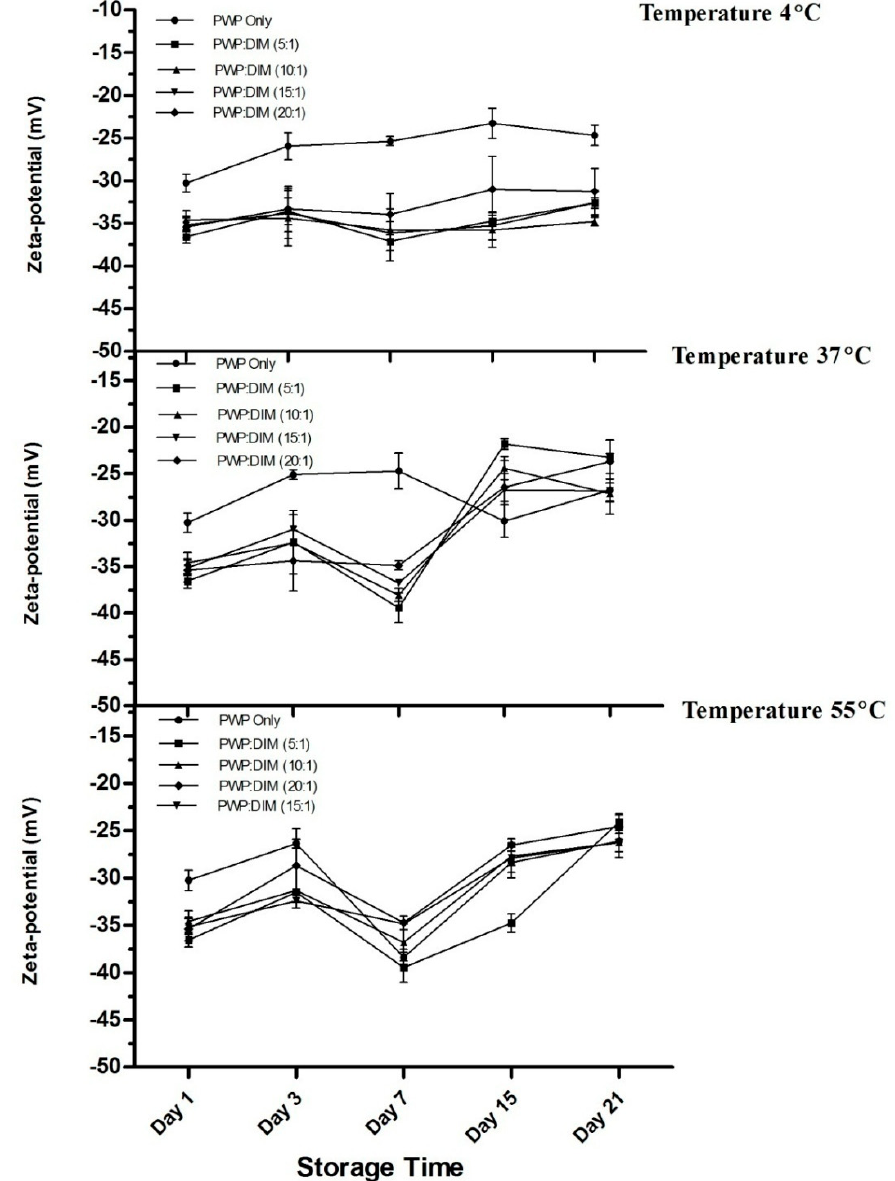
Figure 8. Effect of different storage temperatures (4, 37 and 55 °C) on the mean zeta potential of PWP/DIM nanoparticles with different ratios during storage. Values are mean ± SD ( n = 3).